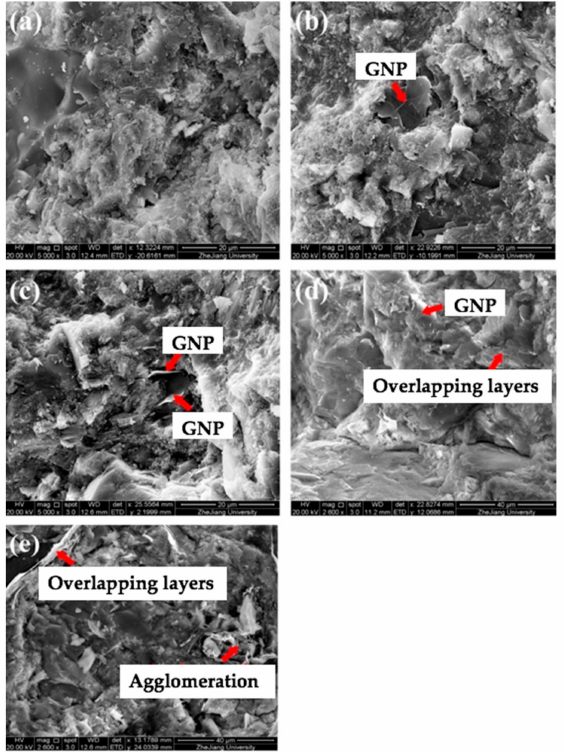
Figure 28. SEM images of the cement mortars added with di ff erent GNP content: ( a ) M0 (0%), ( b ) M1 (0.05%), ( c ) M2 (0.1%), ( d ) M3 (0.5) and ( e ) M4 (1%). Reprinted with permission from [160]. Copyright © 2019, Elsevier B.V.